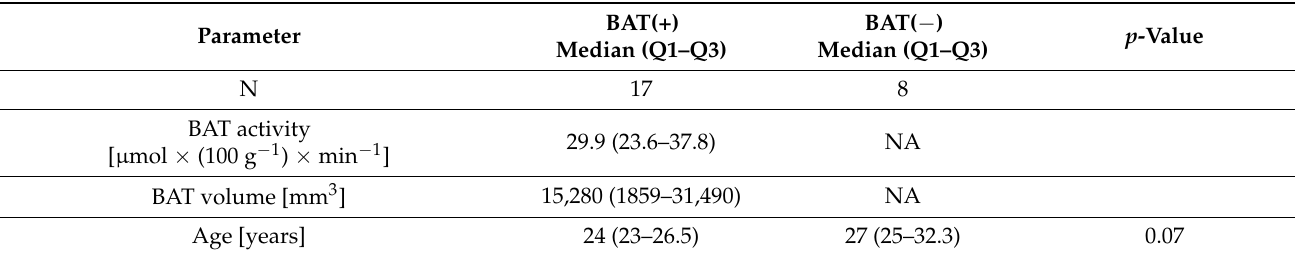
Table 1. Characteristics of BAT(+) and BAT( − )